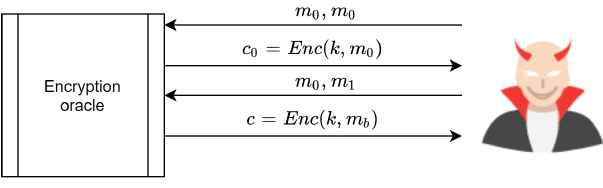
Figure 23. Steps needed for an adversary to win the Chosen Plain Text Attack (CPA)